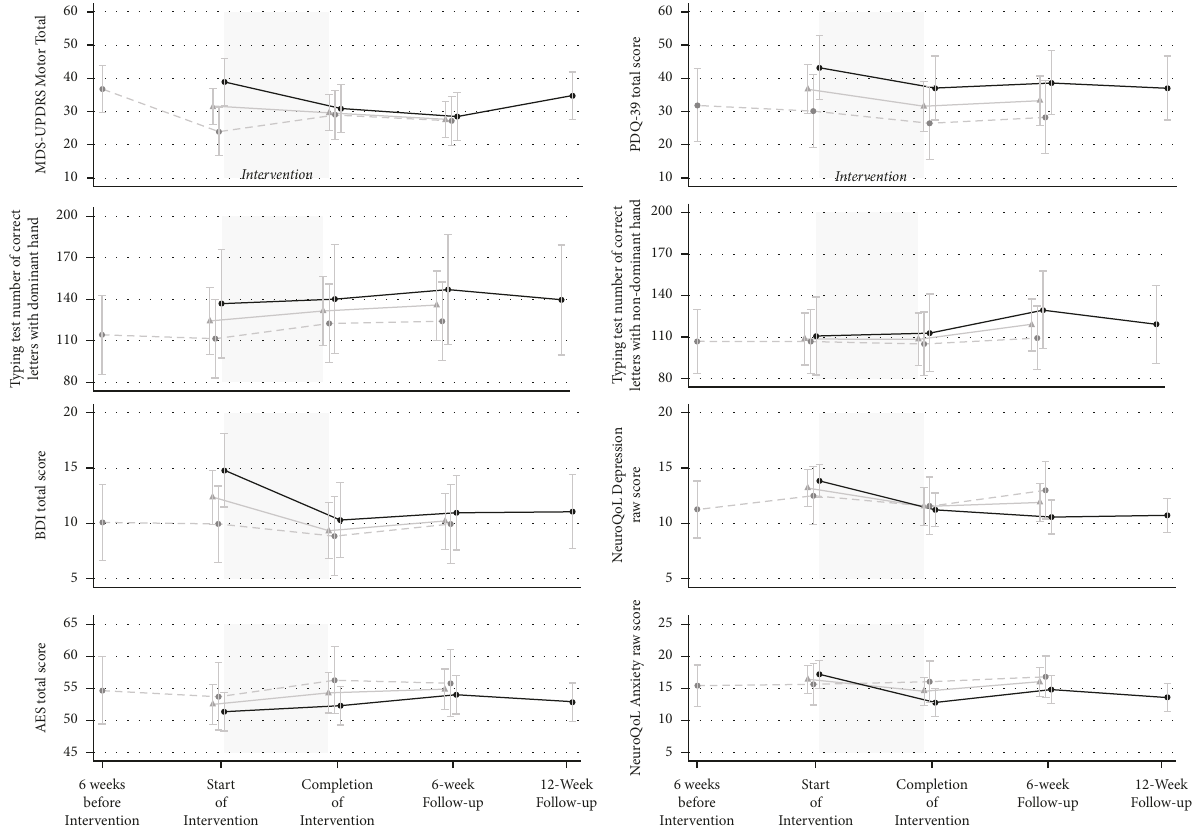
Figure 3: Combined and stratified analysis by intervention group-effect of intervention immediately after intervention ( X postintervention (X6wpi) and 12 weeks postintervention (X12wpi; Group 1